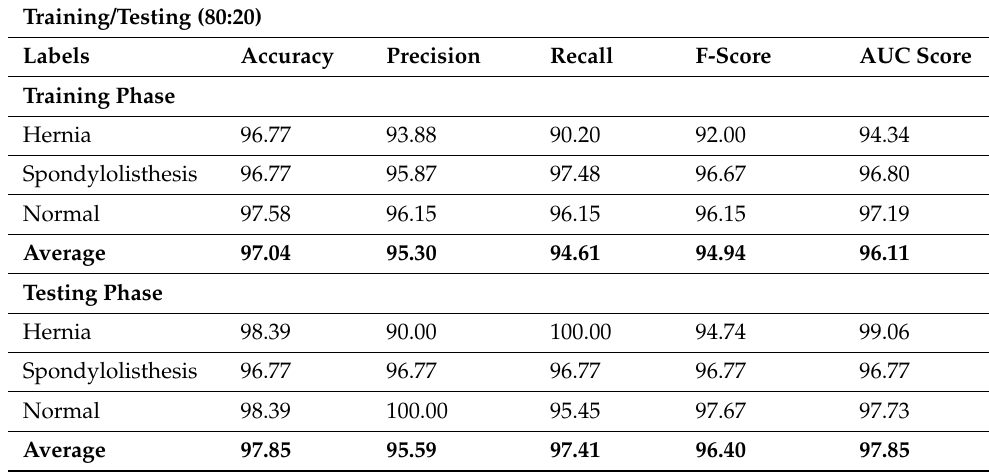
Table 2. RA Classification results of ARAC-AOADL model on 80:20 of TR/TS data.